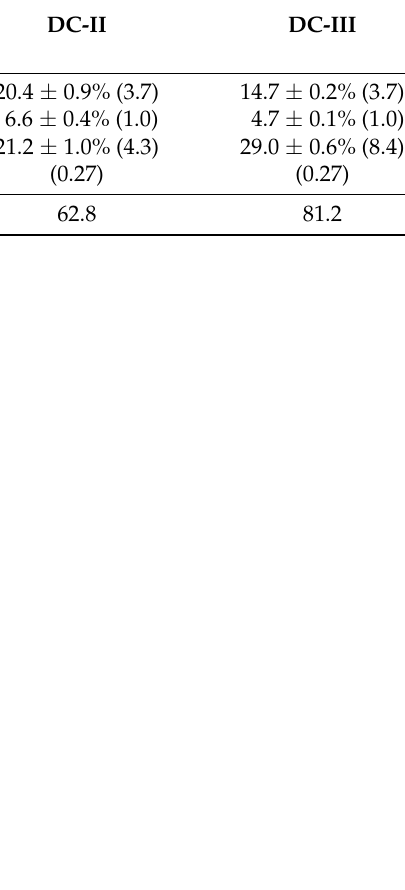
Figure 2. X-ray diffraction patterns of as-received DC-I, DC-II and DC-III. E: enargite (Cu 3 AsS 4 ; PDF No. 00-035-0775), P: pyrite (FeS 2 ; PDF No. 00-042-1340), T: tennantite (Cu 12 As 4 S 13 ; PDF No.